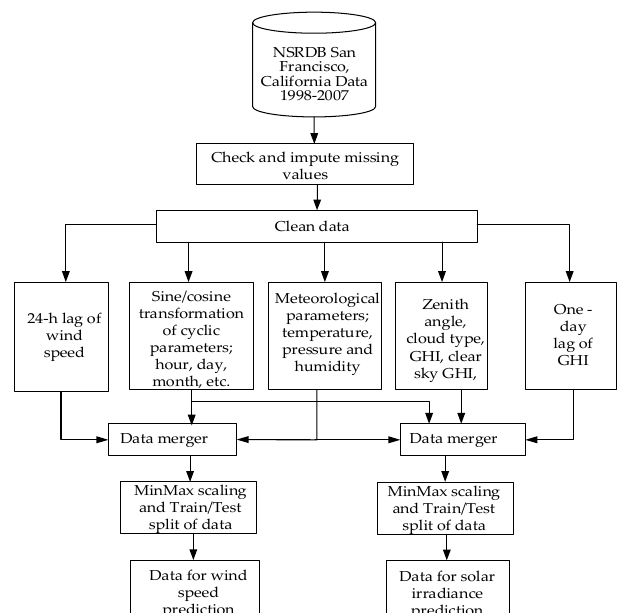
Figure 2. Proposed MH-CNN model.